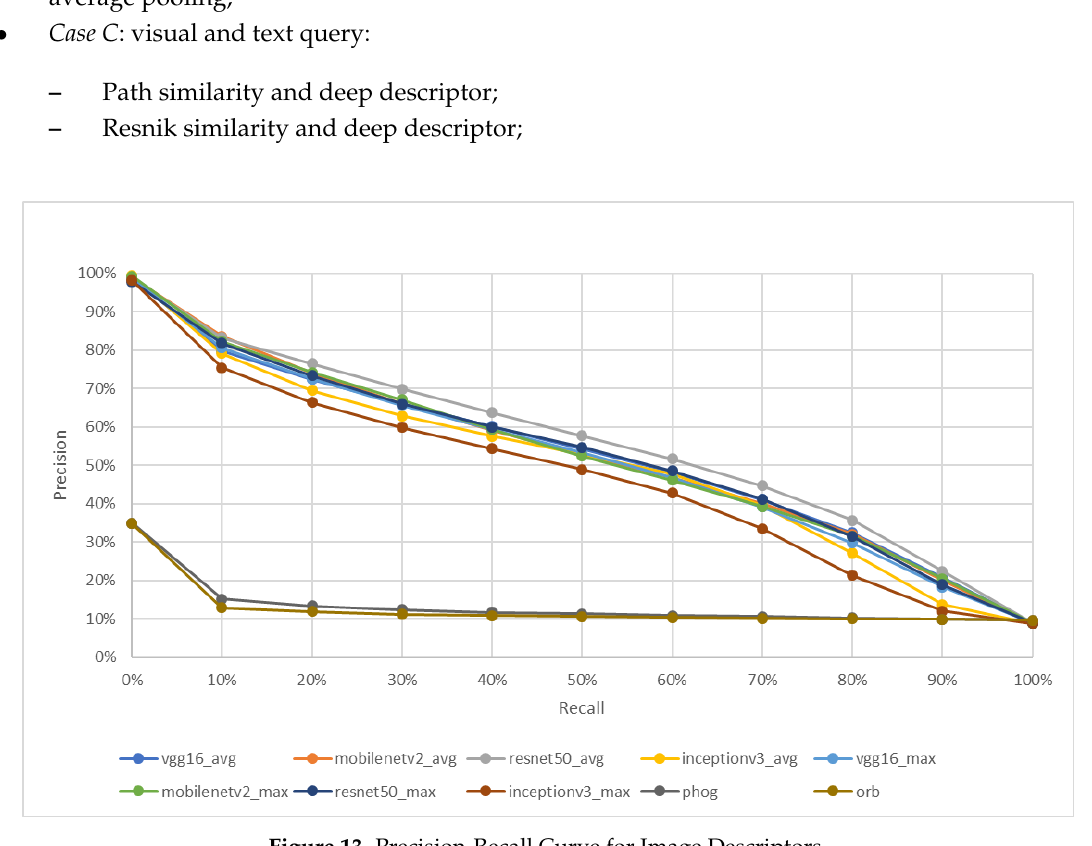
Figure 13. Precision-Recall Curve for Image